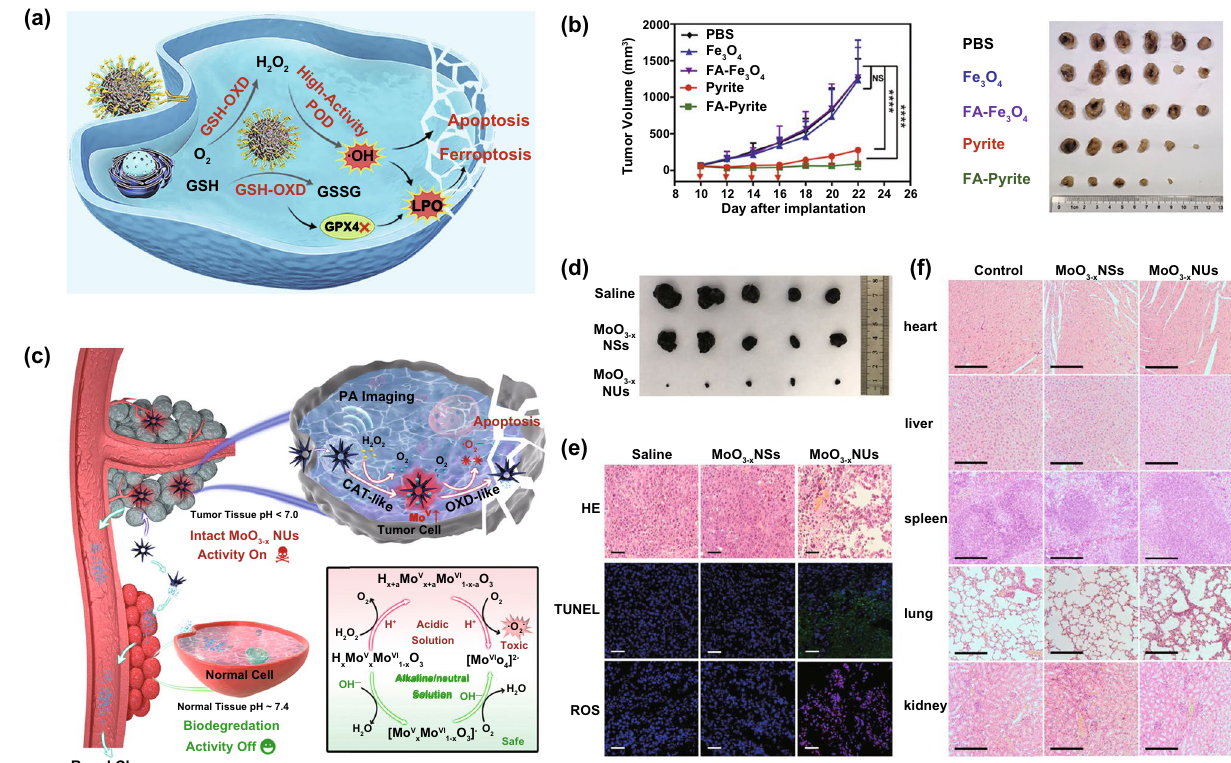
Fig. 10 a Schematic illustration of the self-cascade pyrite nanozymes with both POD- and GSHOx-like abilities for cancer therapy. b In vivo anticancer performance of the pyrite nanozymes. Reproduced with permission from Ref.[126]. Copyright 2021, American Chemical Society. c Schematic illustration of the biodegradable MoO 3−x NUs with both CAT- and OXD-mimicking ability for cancer therapy. d – e In vivo anticancer performance of the pyrite nanozymes of MoO 3−x NUs. f Evaluation on the biosafety of MoO 3−x NUs. Reproduced with permission from